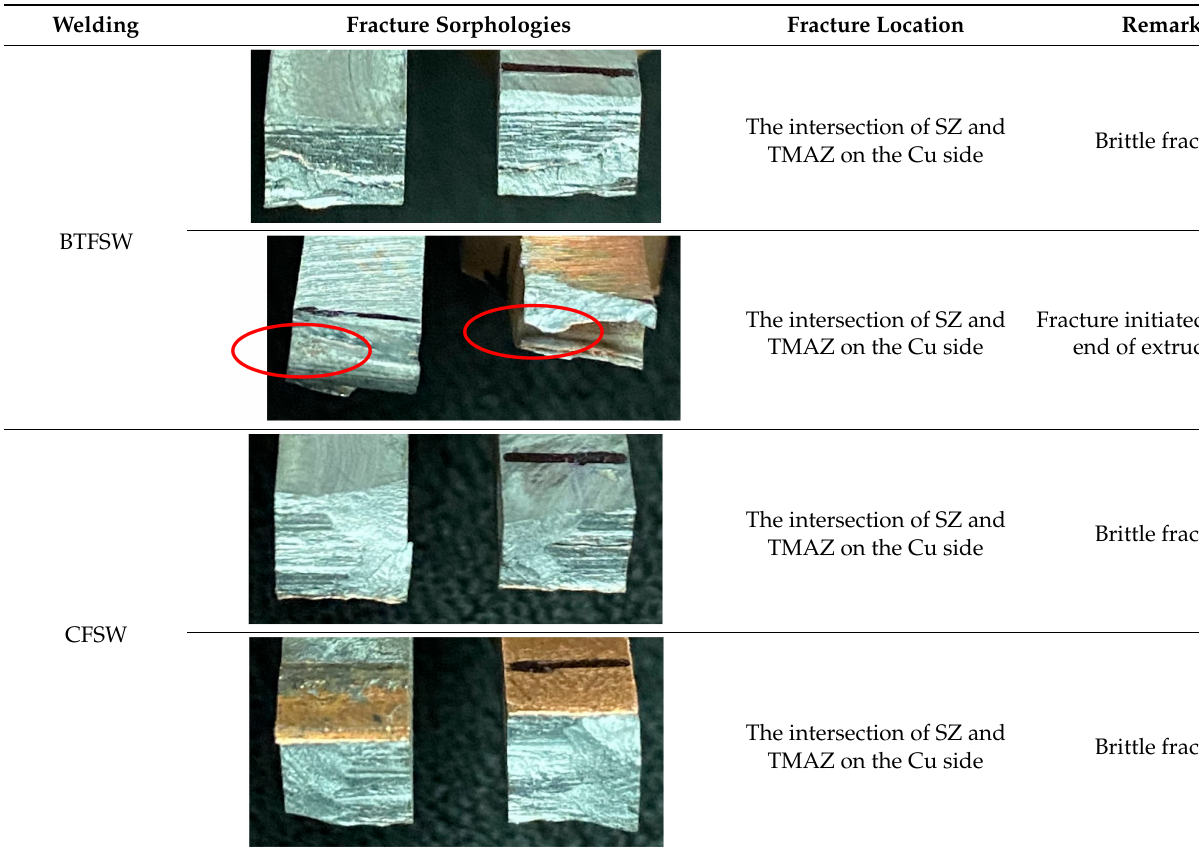
Table 1. Fracture features of the tensile specimens under BTFSW and